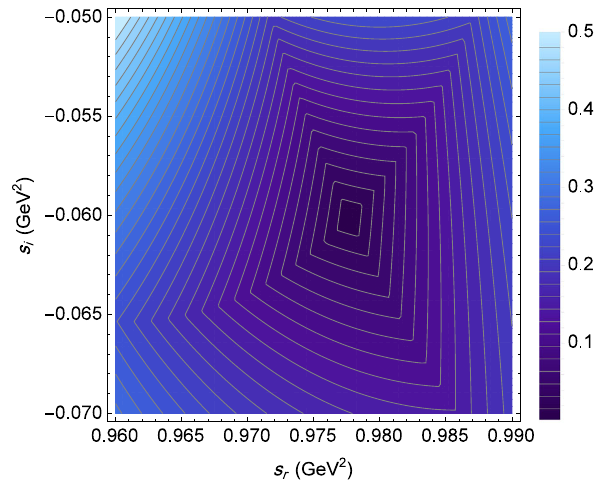
Fig. 13 Contour plot of function F ( s r , s i ) [defined in (55)]. The point at which F = 0 represents the first physical isovector scalar meson pole and provides the properties of the a 0 ( 980